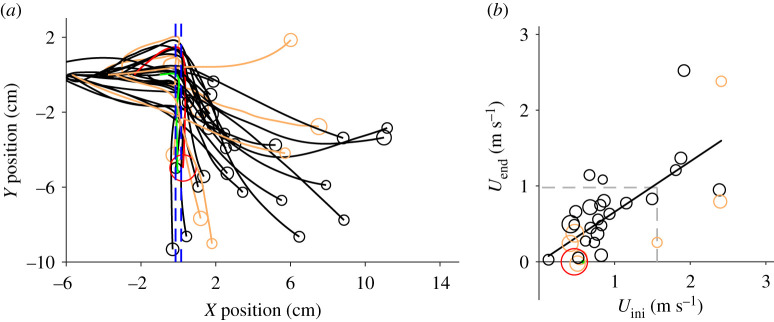
(a) Two-dimensional insect trajectories for dipteran insects: bottle flies: Lucilia sp. (N = 7, orange symbols); house flies, Musca sp. (N = 24; black symbols), one cranefly, Tipula sp. (red symbol), and a fruit fly (Drosophila melanogaster; green symbol). Circle size represents relative body size; the waterfall position is represented by dashed blue lines. (b) Body speed (Uini) prior to waterfall contact versus horizontal speed (Uend) following transit through the water fall. Circle sizes represent relative body size and average speed. Grey broken lines indicate the initial speed (approx. 1.6 m s−1) below which no insect could pass successfully through the waterfall.